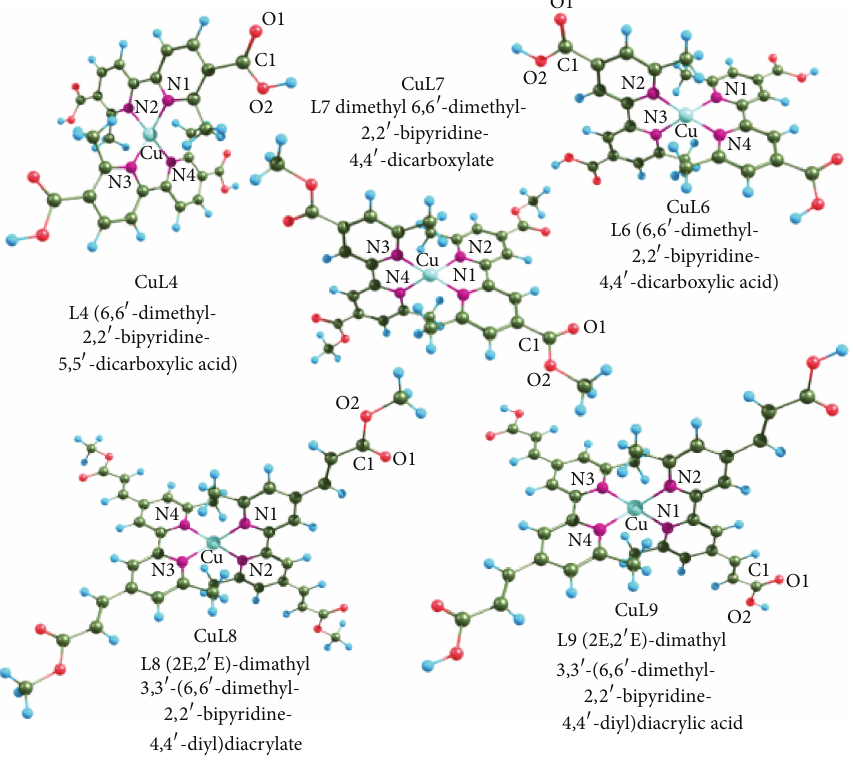
Figure 1: Optimized molecular structures of copper complexes in solution at the M06/LANL 2 DZ + DZVP level of theory.